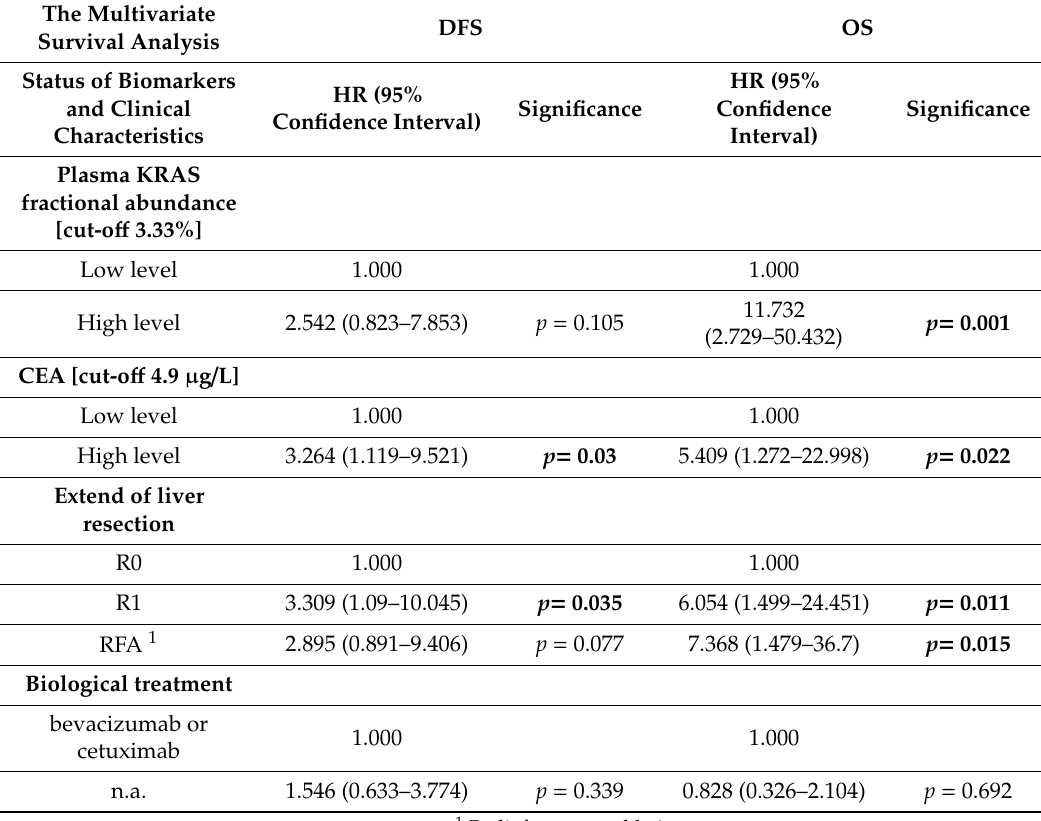
Table 3. The multivariate analysis of disease free survival (DFS) and overall survival (OS) of patients undergoing liver surgery.